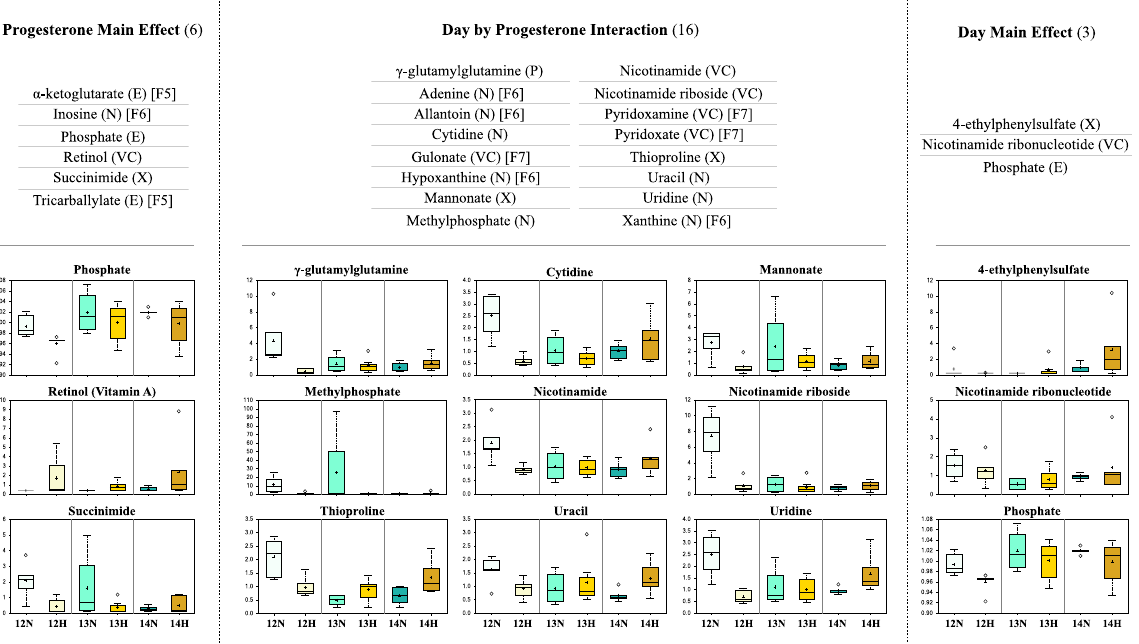
Figure 1. The identified metabolites, and their respective pathways, showing a progesterone (P4) main effect (left), a day main effect (right), and/or a day by P4 interaction (centre). Phosphate showed both a progesterone and day main effect but not a day by P4 interaction. Day and/or P4 main effects are discounted where a day by P4 interaction is displayed. Corresponding metabolite scaled intensities are also provided, wherein the central horizontal line represents the median value with outer boundaries depicting upper and lower quartile limits. The y-axes are the relative metabolite concentrations. Error bars depict the minimum and maximum distributions, with a cross ( + ) representing the mean value and a white circle ( ○ ) the extreme data point. Square brackets denote the figure in which the scaled intensities for the metabolite is provided. Abbreviations: Fig. 5 [F5], Fig. 6 [F6], Fig. 7 [F7], energy metabolite (E), nucleotide metabolite (N), vitamin and cofactor metabolite (VC), xenobiotic (X), peptide (P), Day 12 Normal P4 (12N), Day 12 High P4 (12H), Day 13 Normal P4 (13N), Day 13 High P4 (13H), Day 14 Normal P4 (14N), and Day 14 High P4